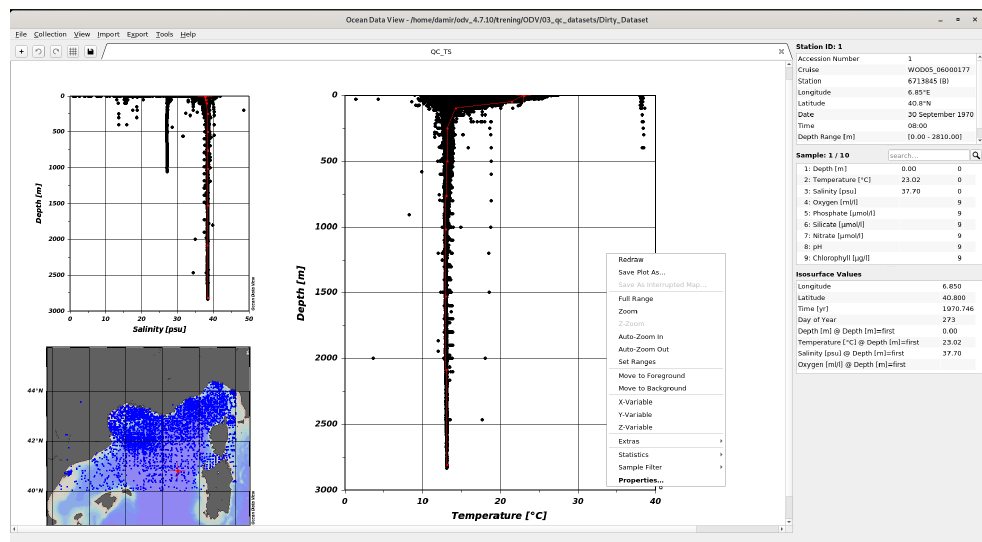
Figure 2. ODV desktop